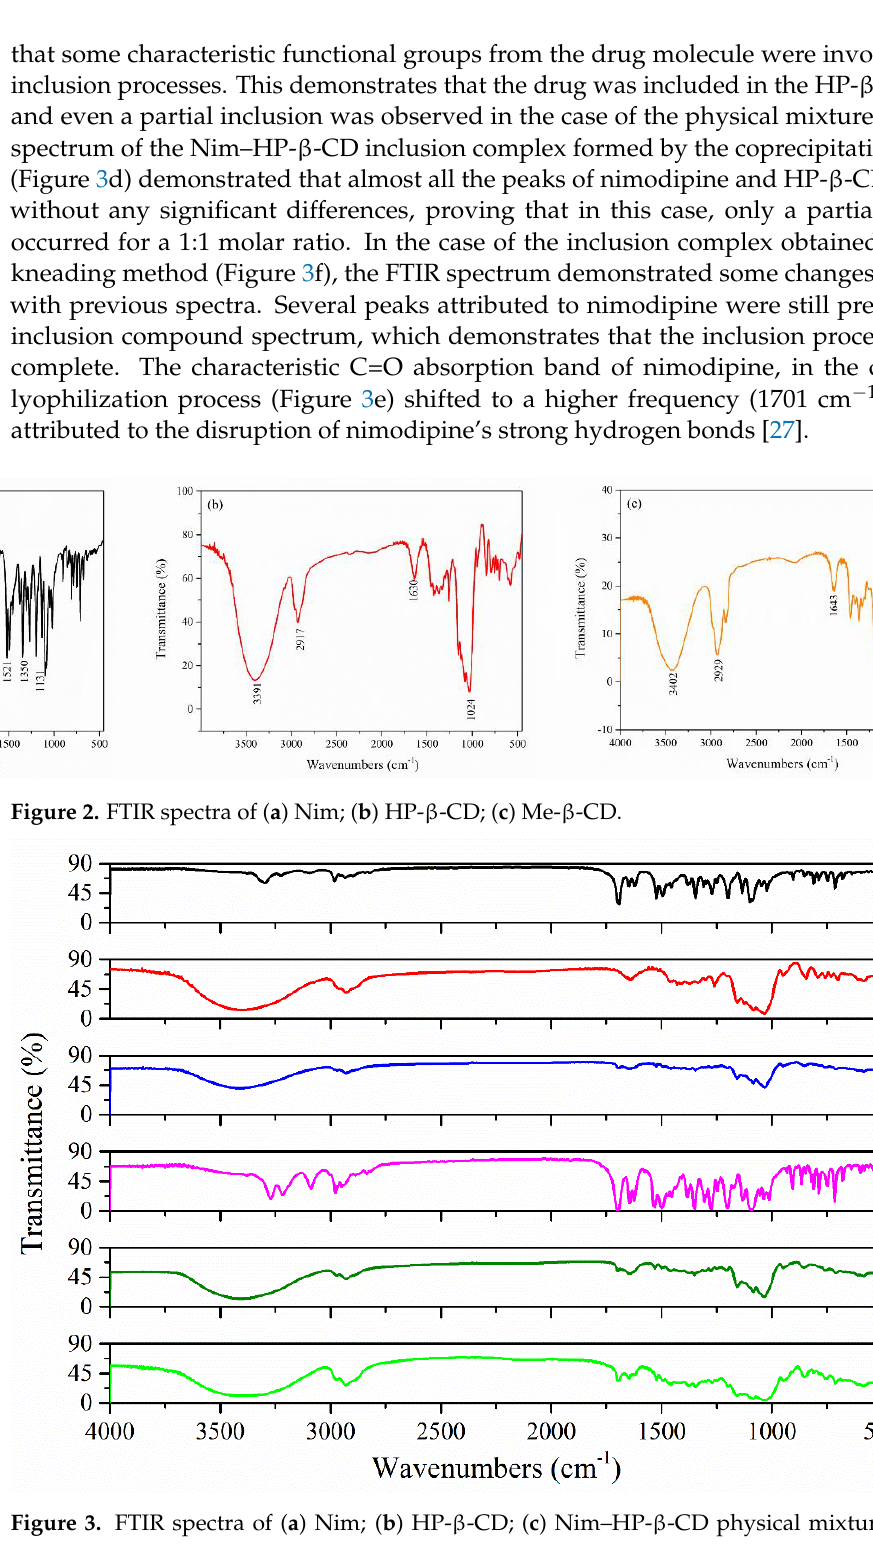
Figure 4. FTIR spectra of ( a ) Nim; ( b ) Me- β -CD; ( c ) Nim – Me- β -CD physical mixture; ( d ) Nim – Me- β -CD coprecipitation method; ( e ) Nim – Me- β -CD lyophilization method; ( f ) Nim – Me- β -CD knead- ing method.